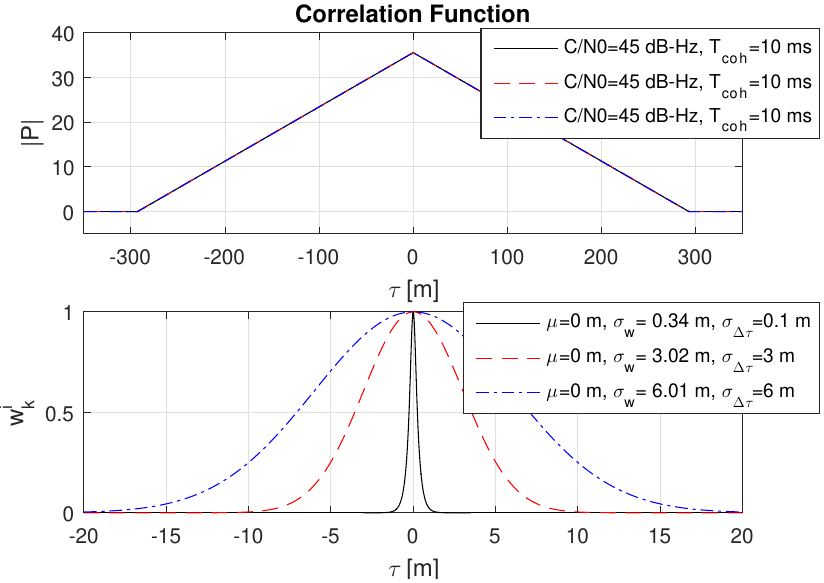
Figure 7. Impact of different code delay bias standard devications σ ∆ τ on the weights w i integration time T coh = 10 ms. It can be seen that σ w approaches the theoretical limits for σ ∆ τ = 3 and σ ∆ τ =